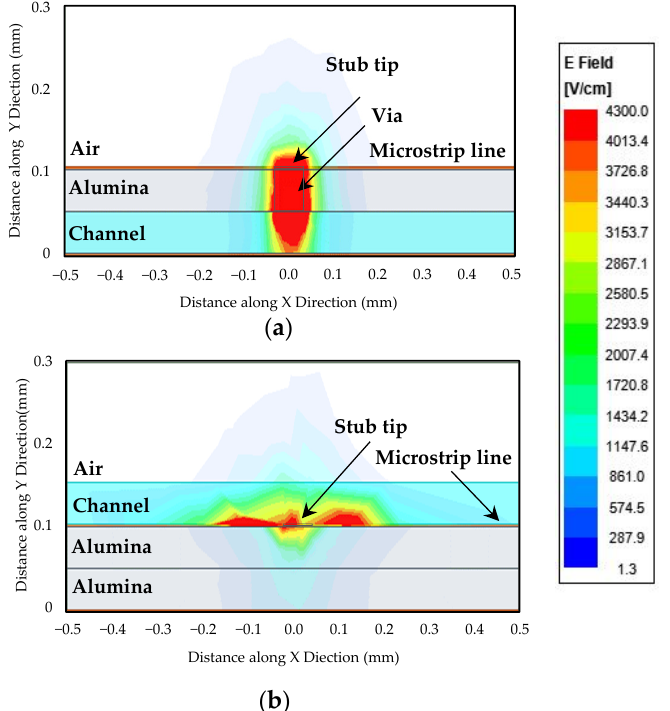
Figure 2. Position of the microchannel and the electric field distribution in: ( a ) the microfluidic